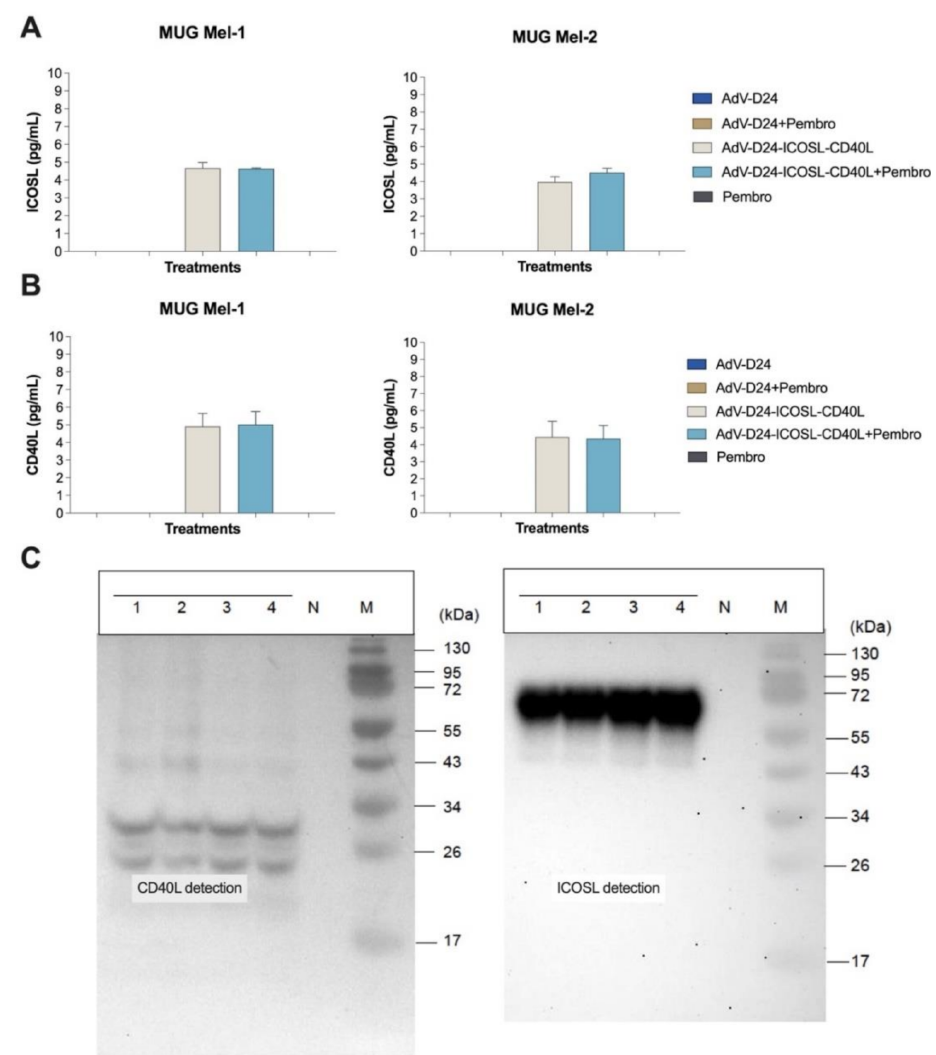
Figure 2. Evaluation of ICOSL and CD40L expression in tested melanoma cells. ( A ) ICOSL concen- tration was detected on supernatants collected 24–48 h after treatment using ELISA kit. ( B ) CD40L was detected from supernatants collected 24–48 h after treatment using an ELISA kit according to the manufacturer’s instructions. Statistical analysis was carried out with a Mann–Whitney test to compare two groups (ns = not significant, p > 0.05). ( C ) Transgene expression. The expression of ICOSL and CD40L from AdV-D24-ICOSL-CD40L was assessed by infecting A549 cells with the virus, harvesting proteins 48 h after the infection and detecting ICOSL and CD40L by Western blot. 1–4: protein extracts from A549 cells infected with AdV-D24-ICOSL-CD40L clones #1–4. N: protein extract from non-infected A549 cells. M: PageRuler Prestained Protein Ladder (ThermoScientific # 26616). ICOSL MW: 70 kDa (due to heavy protein glycosylation); CD40L MW: 30